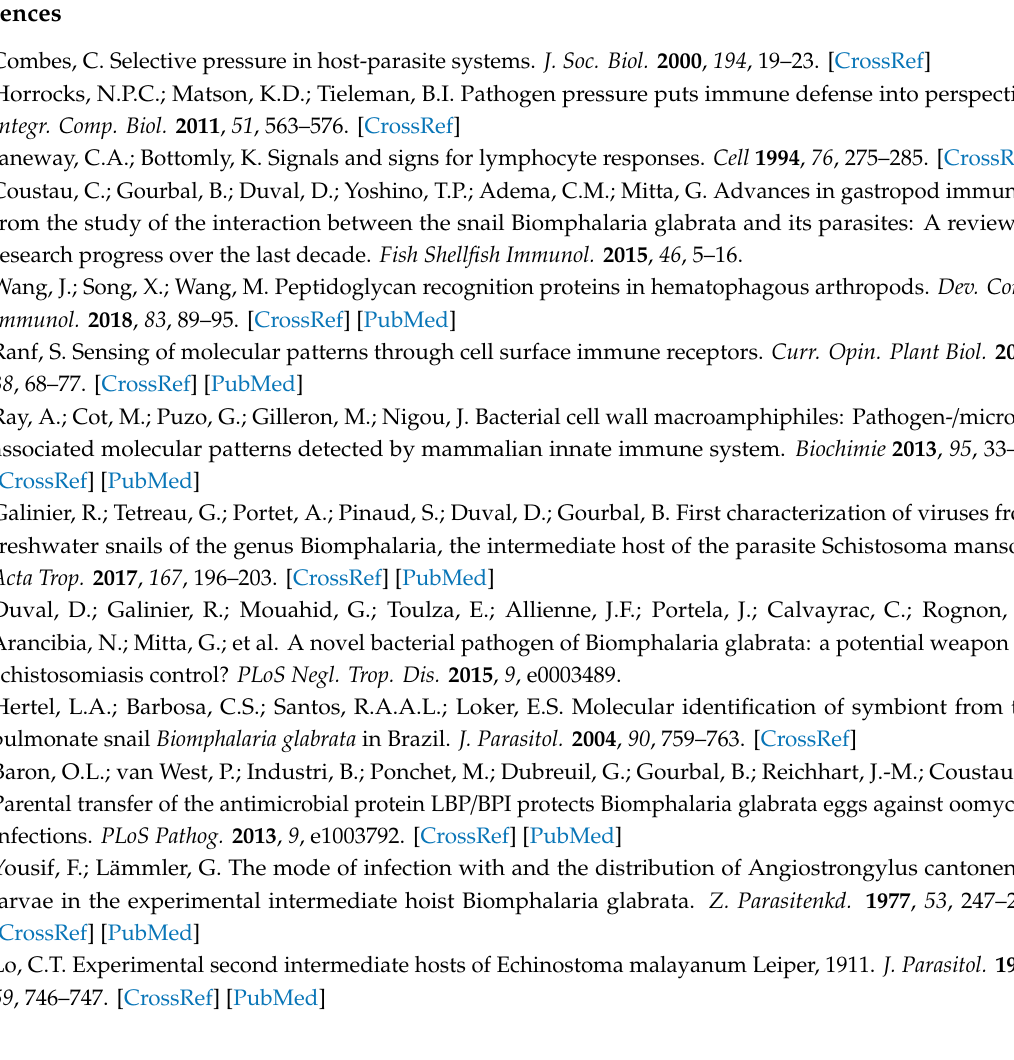
Table S1: Primer sequences used for PCR and qPCR amplifications, Table S2: Nomenclature and genome sequence sca ff old’s position for Glabralysin genes, Table S3: Sequence similarity and identity scores between Glabralysin